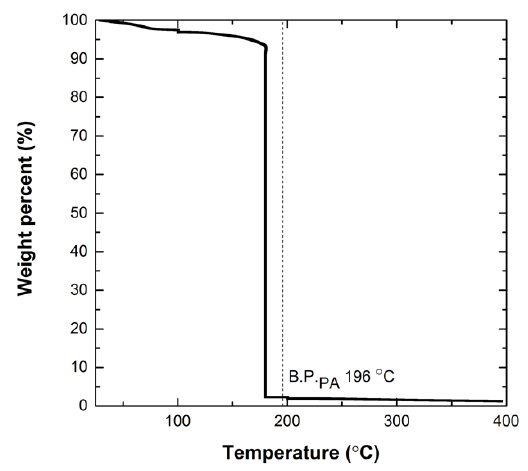
Figure 4. Thermogravimetric analysis (TGA) of microcapsules filled with MMI2/PA. Microcapsules used in TGA have diameters of 200 µ m and less. Capsule specimens were heated at a rate of 5 ◦ C min [1] to 100 ◦ C and held for 30 min to stimulate water loss. This was followed by heating to 180 ◦ C for 30 min and 200 ◦ C for 60 min, which bracketed the boiling point of PA (b.p. 196 ◦ C).